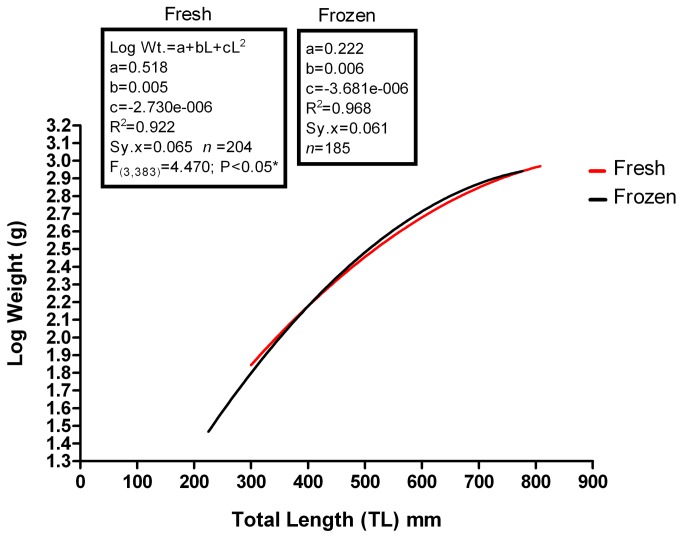
A comparison of fresh and frozen L:W curves.The curves are significantly different, with frozen specimens weighing slightly less at a given TL.